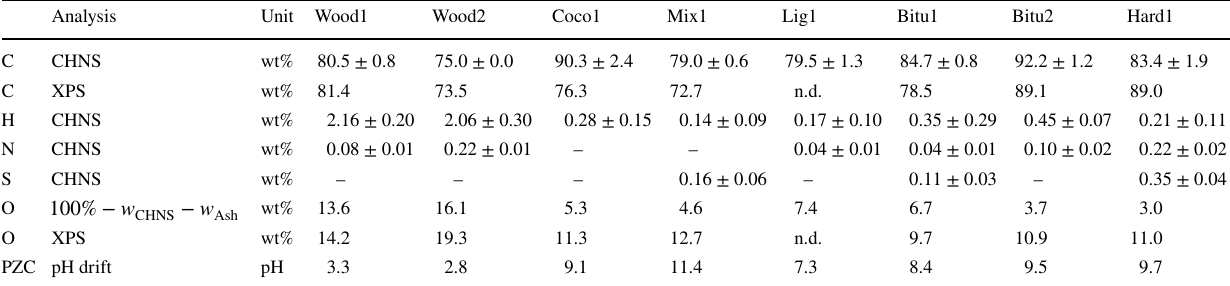
Table 3 Elemental composition of carbon, hydrogen, nitrogen, sulfur, and oxygen and the point of zero charge (PZC) for the eight PACs Analysis Unit Wood1 Wood2